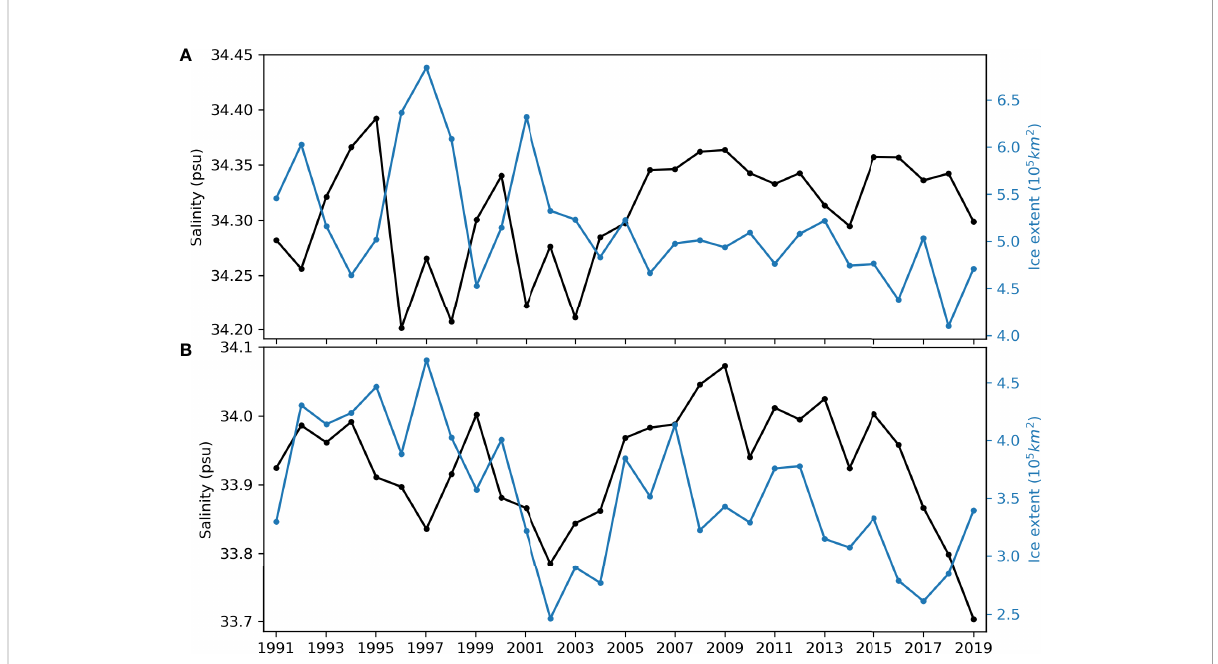
FIGURE 11 Time series plot of mean near-surface salinity in the Greenland Sea (black line) and sea ice extent (light blue line) during (A) January to June and (B) July to December.